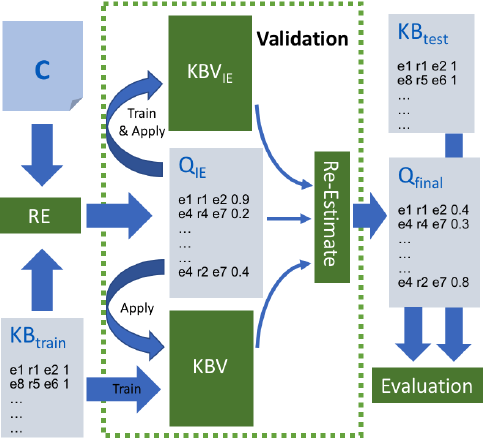
Figure 2. Pipeline for our RE